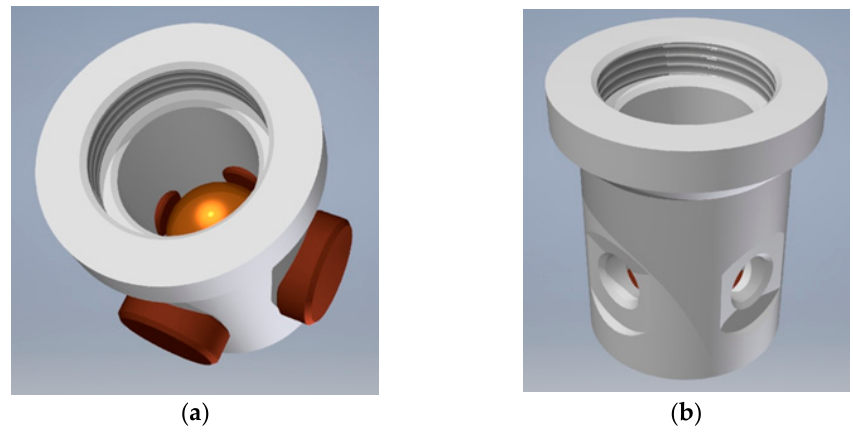
Figure 17. Cylindrical shape of the sensor illustrated in Figure 12a: ( a ) structural members; ( b ) shape of the casing (without the upper